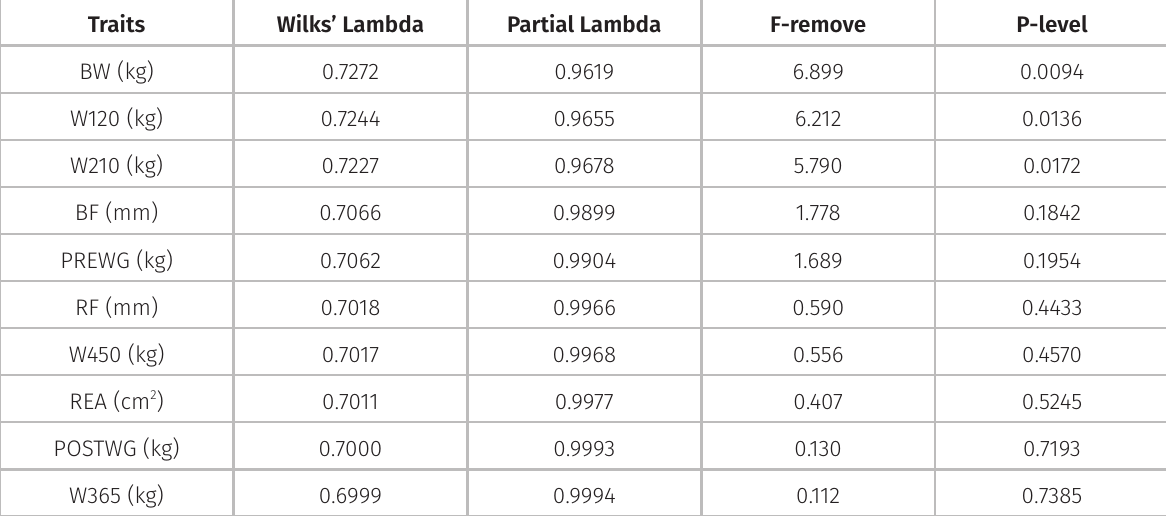
Table IV. Discriminant analysis between growth and carcass traits with early pregnancy heifer diagnostic.